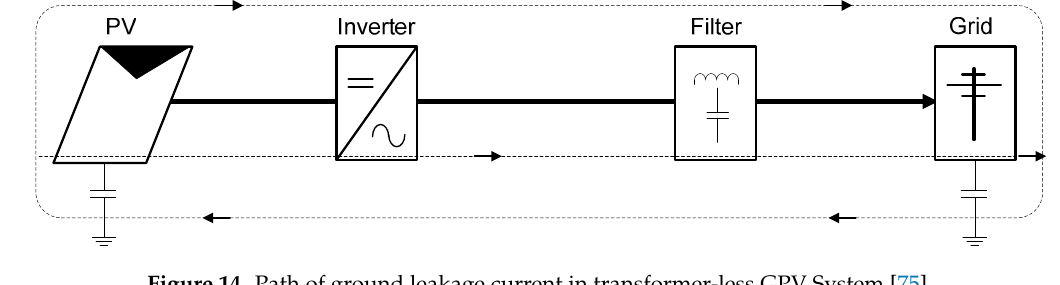
Figure 14. Path of ground leakage current in transformer-less GPV System [75].